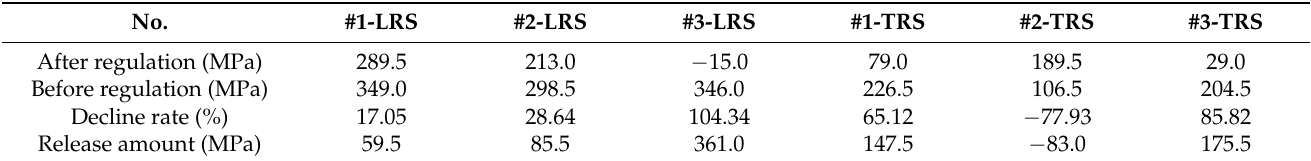
Table 7. Peak residual stress changes on the reverse side of samples #1, #2, and